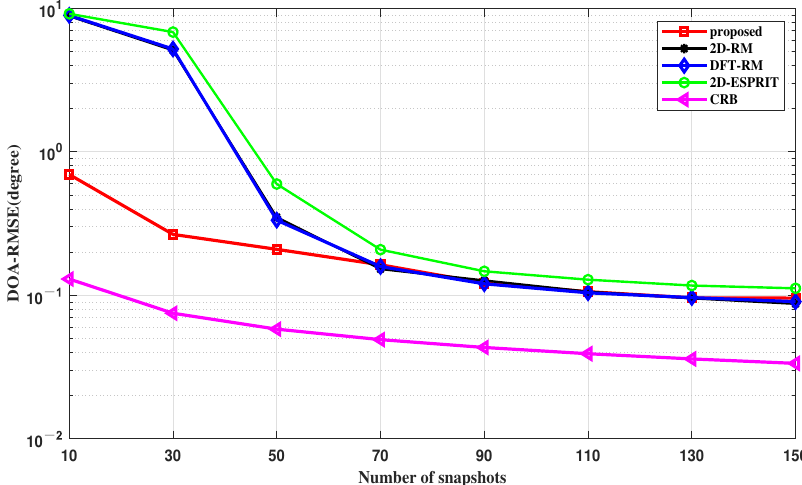
Figure 7. RMSE of the DOA estimation versus